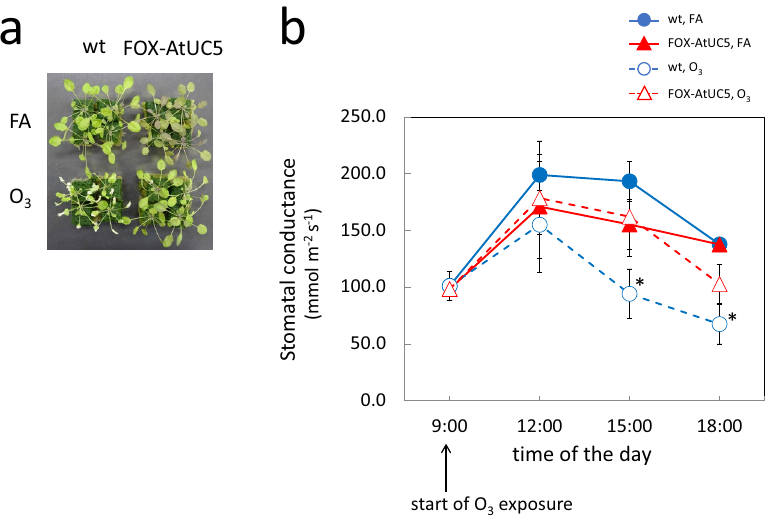
Figure 2. Foliar and stomatal response to O 3 of AtUC5 grown under a short-day condition. ( a ) Images of wild-type and FOX-AtUC5 plants grown under a condition of 8-h light at 100 µmol m −2 s −1 /16-h dark for 5 weeks and exposed for 8 h to fresh air or 0.3 µL L −1 O 3 under 420 µmol photons m −2 s −1 illumination, followed by a further exposure to fresh air for 1 day. ( b ) Stomatal conductances of wild-type and FOX-AtUC5 plants grown and treated in these ways, measured at various hours after the start of O 3 exposure. The averages and SD are shown ( n = 5); asterisks indicate significantly different values from those of the wild-type plants at each timepoint exposed to fresh air ( p < 0.05). wt wild type, FA fresh